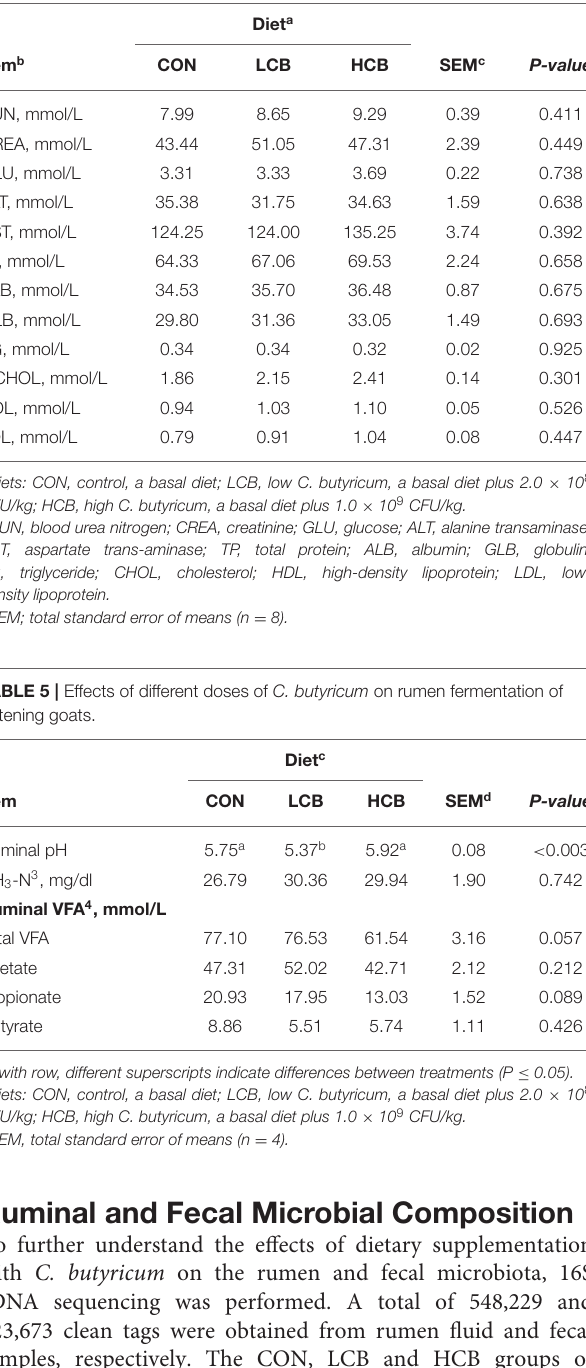
TABLE 4 | Effects of different doses of C. butyricum on serum metabolites of TABLE 2 | Effects of different doses of C. butyricum on growth of fattening goats. fattening goats. Diet a Diet a Item CON LCB HCB SEM b P-value Item b CON LCB HCB SEM c P-value